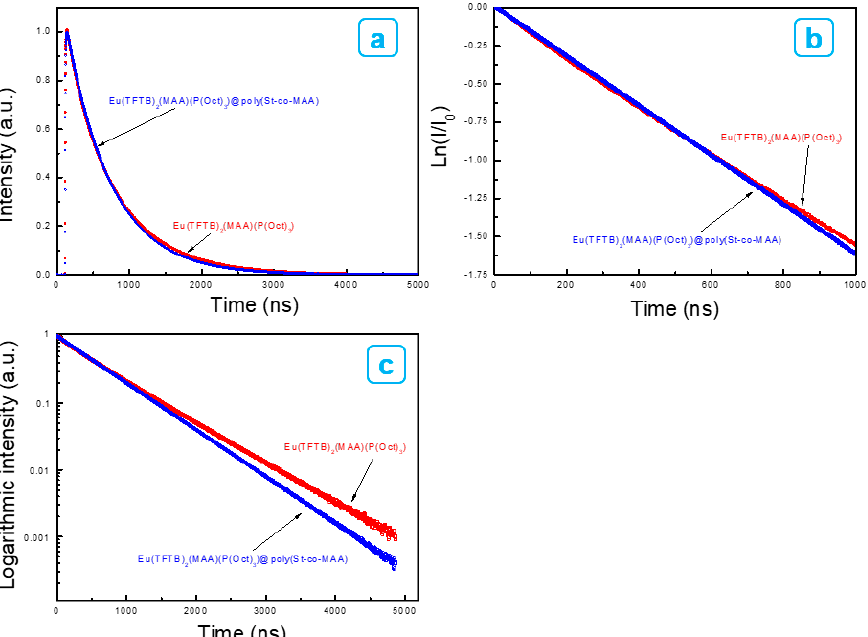
Figure 7. Luminescence decay curves for Eu(TFTB) 2 (MAA)(P(Oct) 3 ) (red) and Eu(TFTB) 2 (MAA)(P(Oct) 3 )@poly(St- co -MAA) (blue) dispersed in water ( λ em = 615 nm, λ ex = 375 nm). Plotted with ( a ) time (ns) versus intensity, ( b ) time (ns) versus natural logarithm (I/I 0 ) and ( c ) time (ns) versus logarithmic intensity.